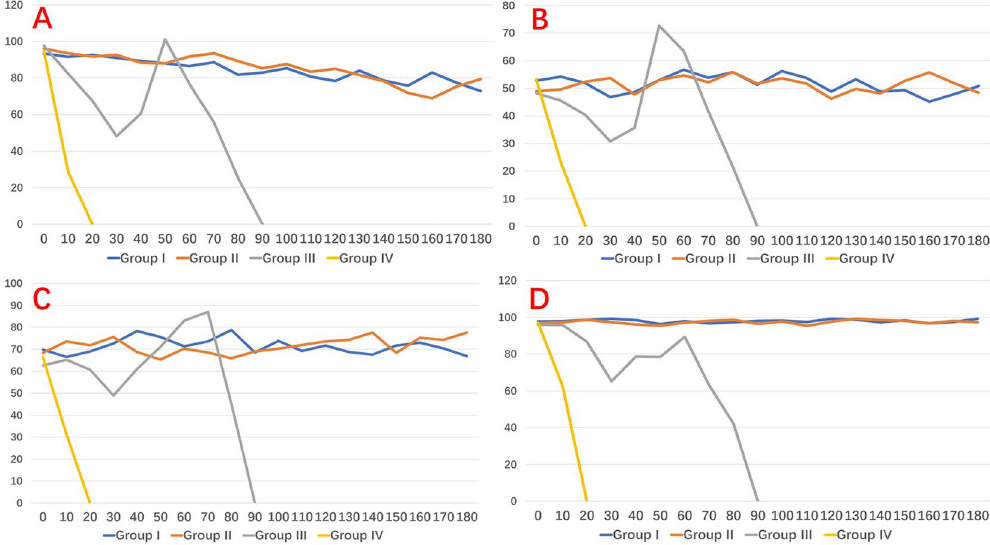
Figure 5. Hemodynamic parameters during experimental study, stratified per group. ( A ) Systolic pressure. ( B ) Diastolic pressure. ( C ) Heart rate. ( D ) Oxygen